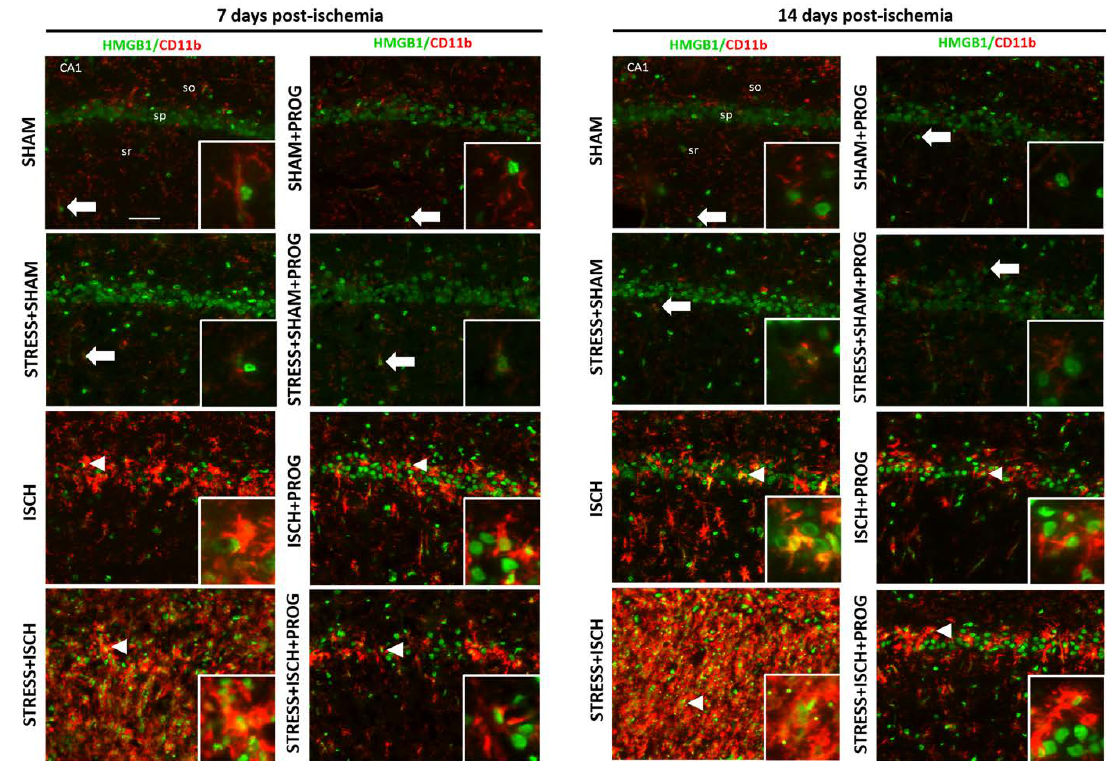
Figure 2. Effects of stress and progesterone on HMGB1 distribution in activated microglia. Representative E ff ects of stress and progesterone on HMGB1 distribution in activated microglia. immunofluorescence merged images showing the distribution of HMGB1 (green) and CD11b positive Representative immunofluorescence merged images showing the distribution of HMGB1 (green) microglia (red) in the hippocampal CA1 region at 7 and 14 days after global ischemia, or from sham and CD11b positive microglia (red) in the hippocampal CA1 region at 7 and 14 days after global animals. White arrows indicate HMGB1 located in the nuclei of surveillant microglia in sham animals; ischemia, or from sham animals. White arrows indicate HMGB1 located in the nuclei of surveillant white arrowheads indicate HMGB1 translocated from the nucleus to the cytoplasm of activated microglia microglia in sham animals; white arrowheads indicate HMGB1 translocated from the nucleus to the in ischemic animals. Right squares show enlargements of selected cells. so, stratum oriens ; sp, stratum cytoplasm of activated microglia in ischemic animals. Right squares show enlargements of selected pyramidale ; sr, stratum radiatum . Scale bar: 50 μm. cells. so, stratum oriens ; sp., stratum pyramidale ; sr, stratum radiatum . Scale bar: 50 µ